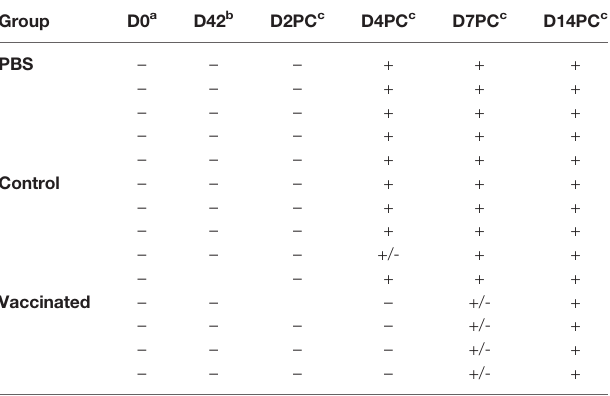
TABLE 3 | PPRV N antigen seroconversion.